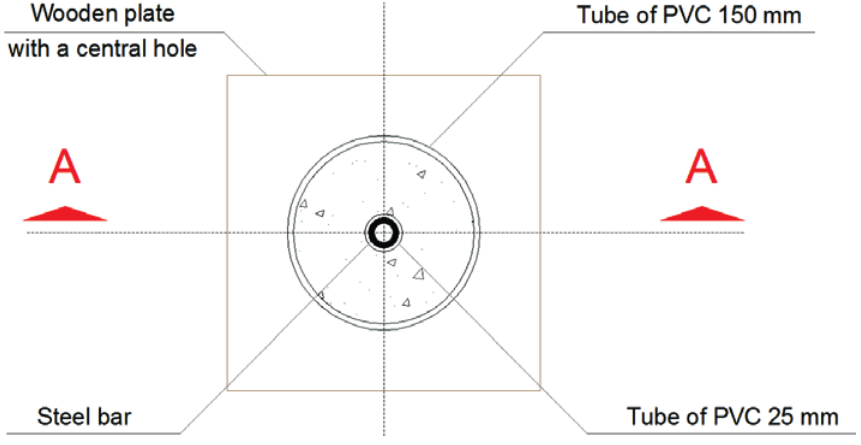
Adherence between steel bars and lightweight concrete with EPS beads